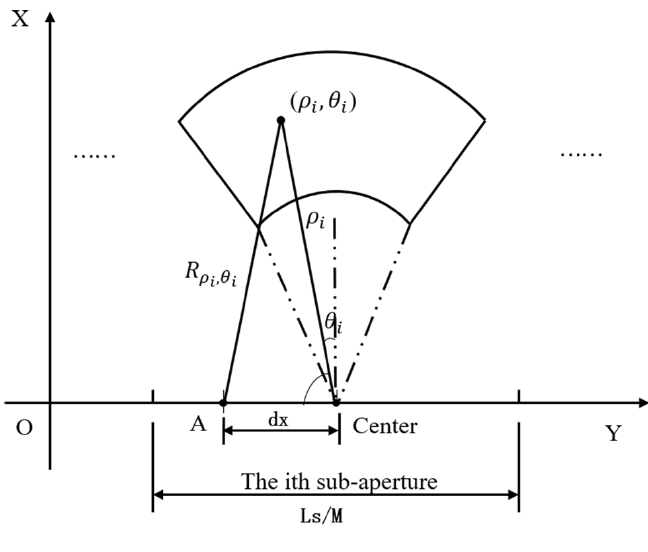
Figure 3. FBP algorithm.